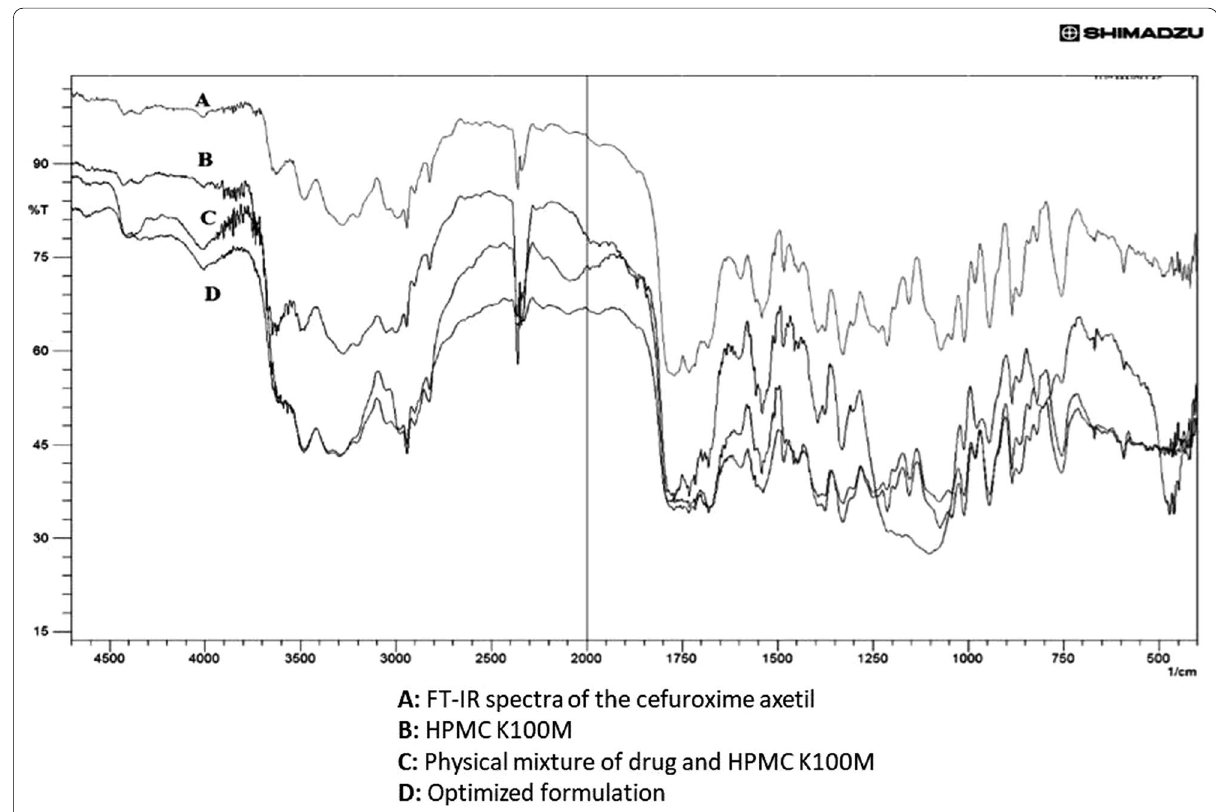
Fig. 4 FT-IR spectra of the cefuroxime axetil ( A ), HPMC K100M ( B ), physical mixture of drug and HPMC K100M ( C ) and optimized formulation ( D )